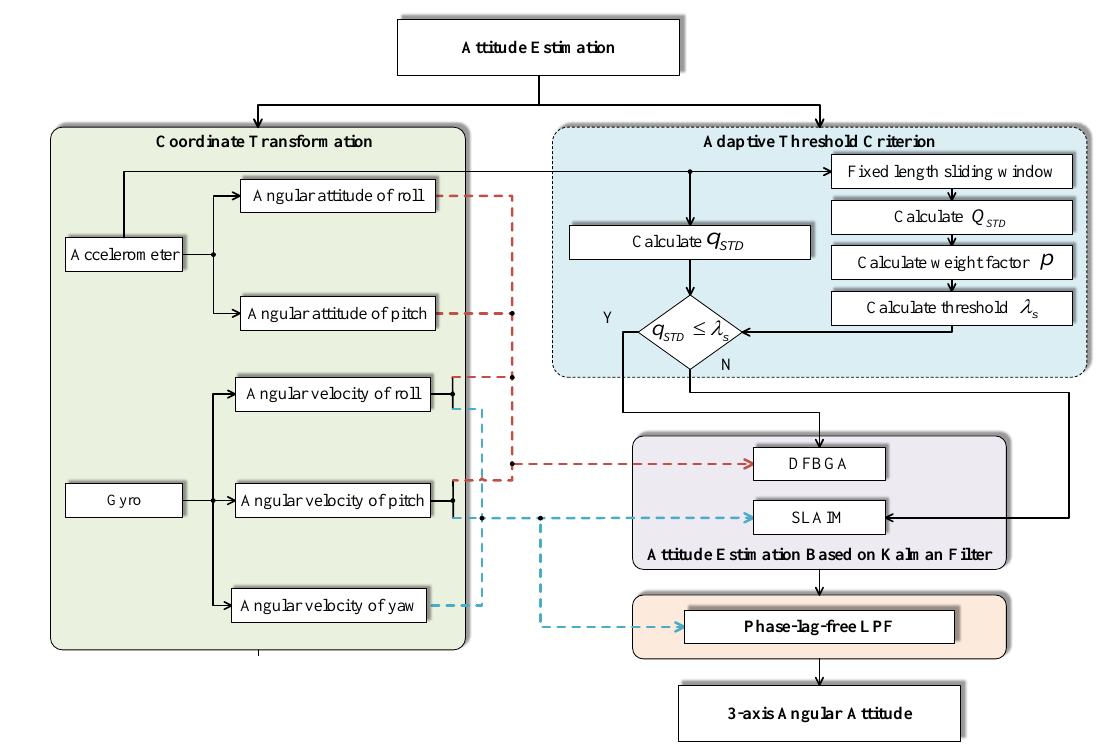
Figure 2. Attitude estimation algorithm flow